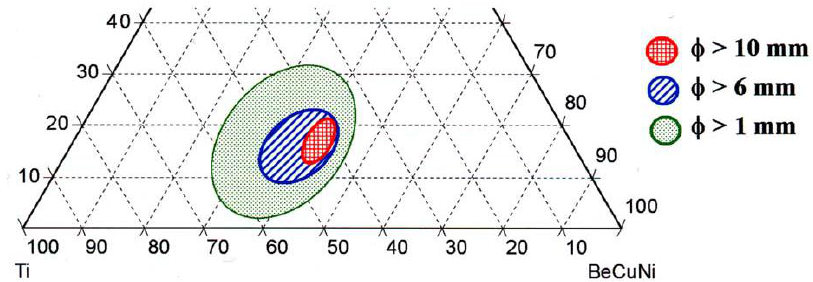
Figure 7. Schematic pseudo Ti–Zr–(Cu, Ni, Be) ternary diagram showing the outline of composition range for maximum diameter for glass formation of 1, 6, and 10 mm. Reproduced with permission from [121]. Copyright 2005, Elsevier.